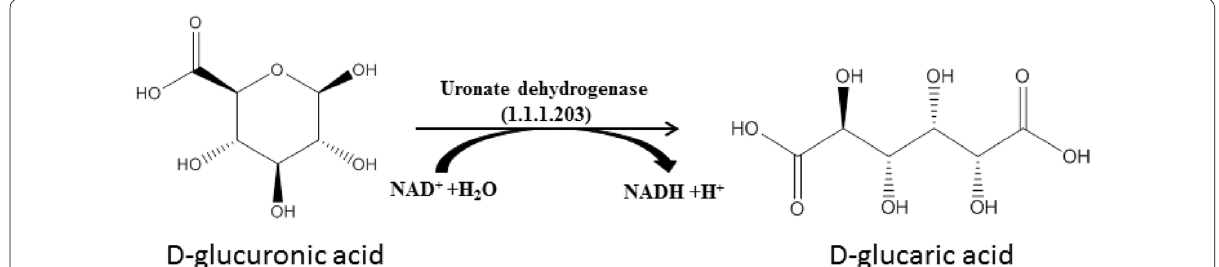
Fig. 1 Uronate dehydrogenase catalyzes a dehydrogenation reaction at C1, 6 position of glucuronic